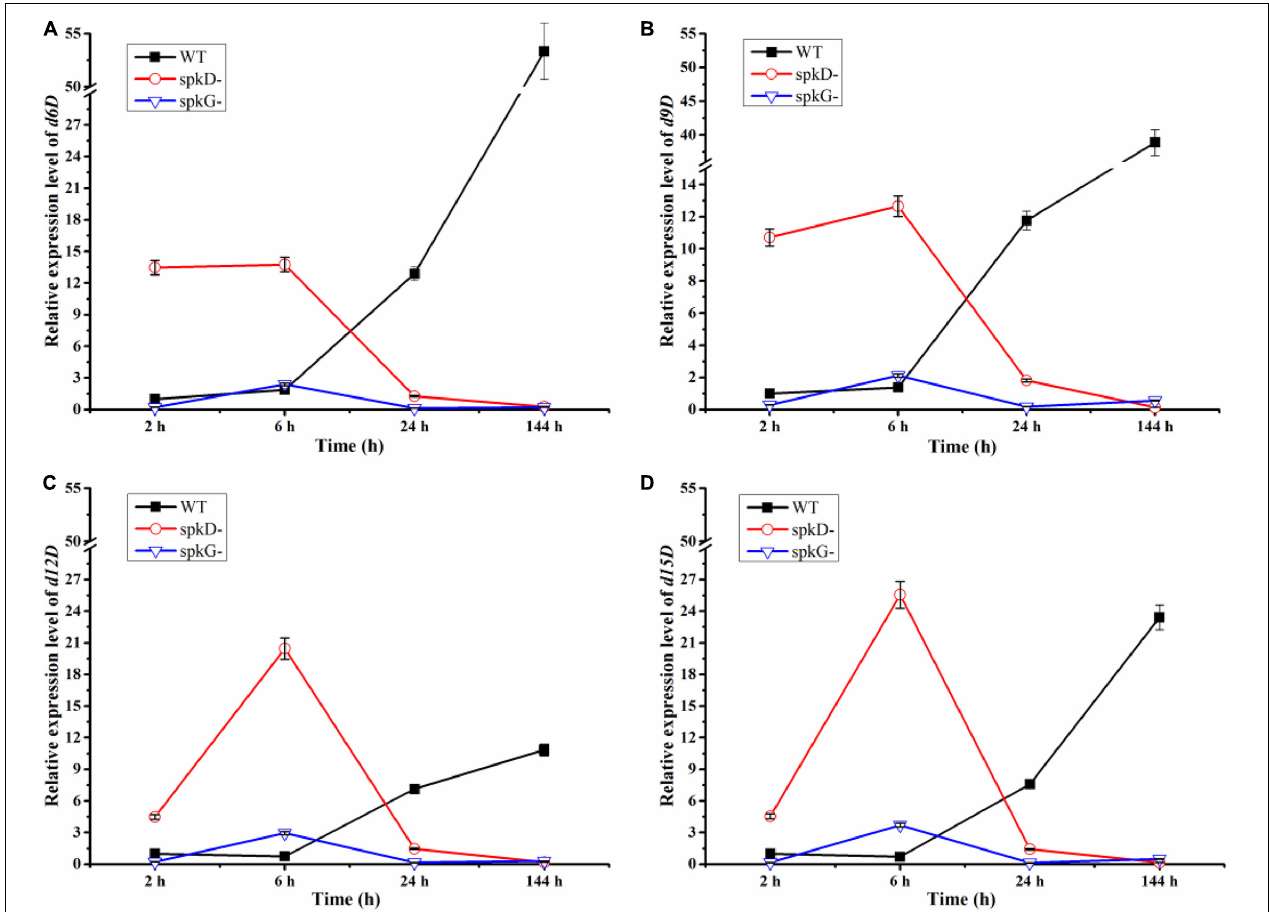
FIGURE 4 | Changes in fatty acid desaturases gene expression in the wild type, spkD and spkG knockout mutants under normal light conditions. WT represents wild type Synechocystis sp. PCC6803; spkD - represents the spkD knockout mutant; spkG - represents the spkG knockout mutant. The experiment was carried out under a normal light intensity of 40 µ mol · m − 2 · s − 1 . ( A–D show the relative expression levels of the d6D, d9D, d12D, and d15D fatty acid desaturases genes, respectively, in wild type Synechocystis sp. PCC6803 and the two knockout mutants) Values are means ± SD (bars) of three independent experiments conducted on different days. The absence of a bar indicates that the SD falls within the